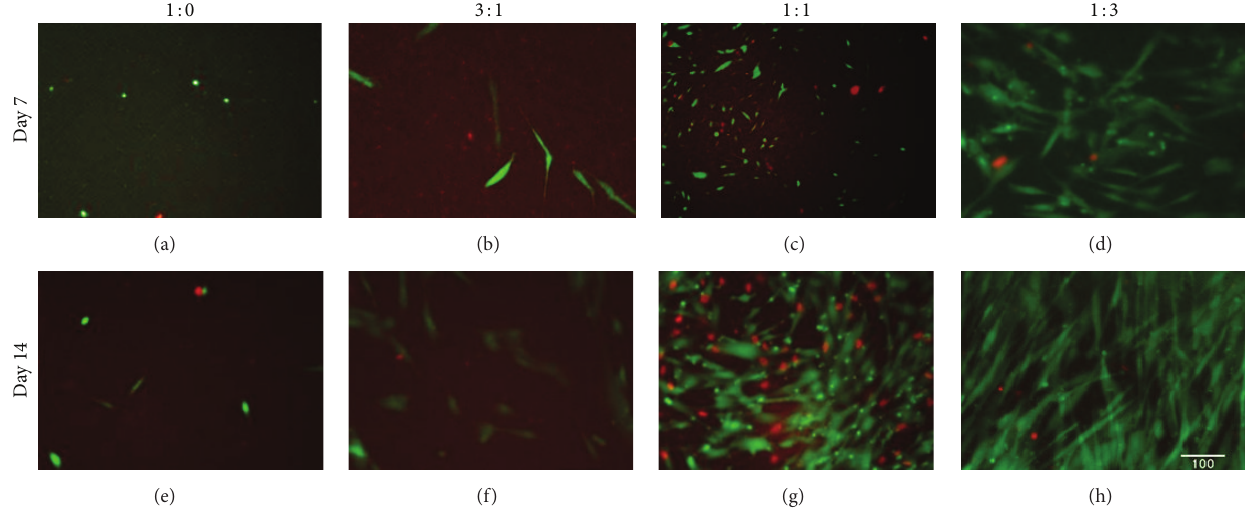
Figure 2: Immunofluorescence results for live/dead staining of human dental pulp stem cells embedded in 2.0% (w/v) PEGSSDA and varying (v/v) ratios of HA:GN. Green = live cells. Red = dead cells. Magnification = 20x. Scale bar = 100 𝜇 m.